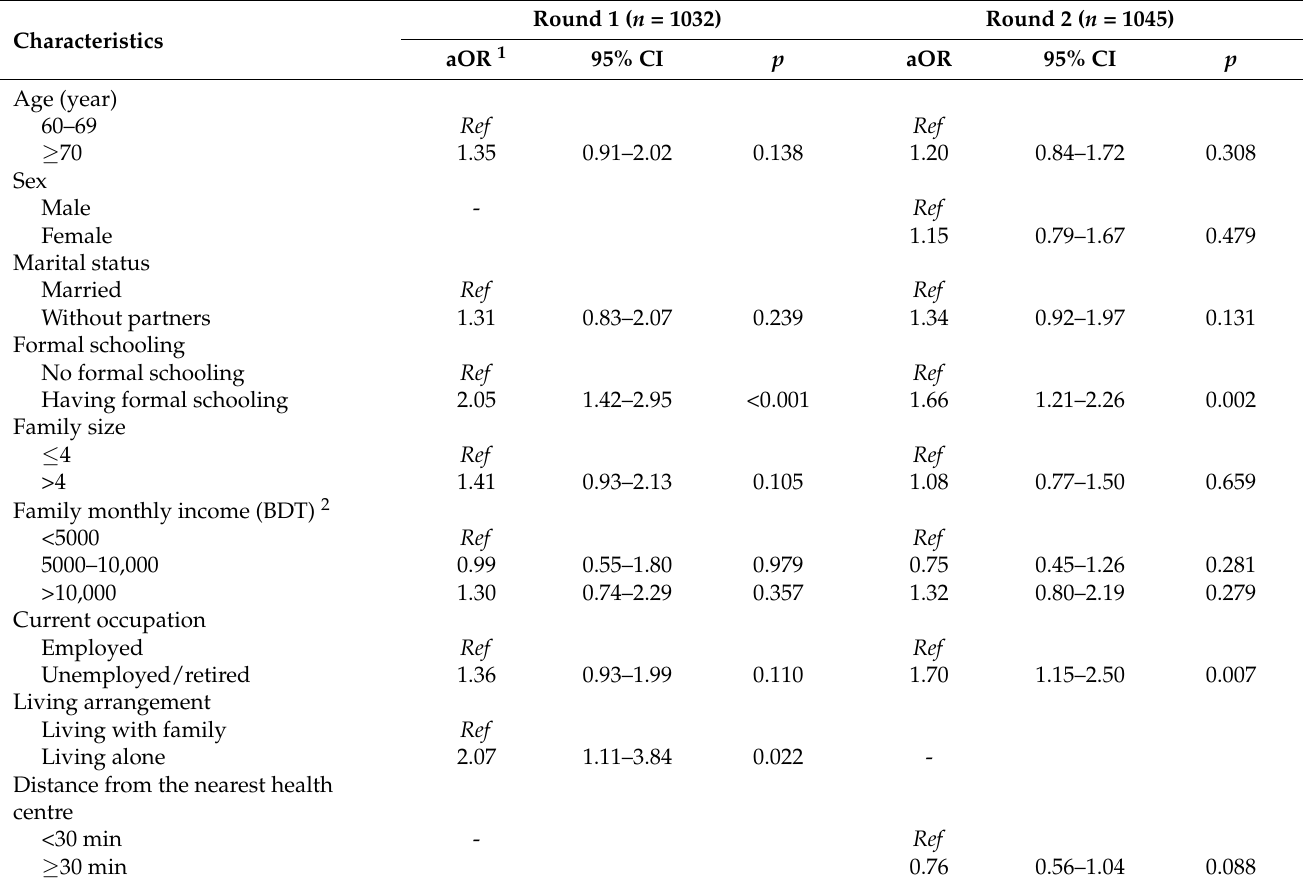
Table 4. Changes in factors associated with hypertension among the